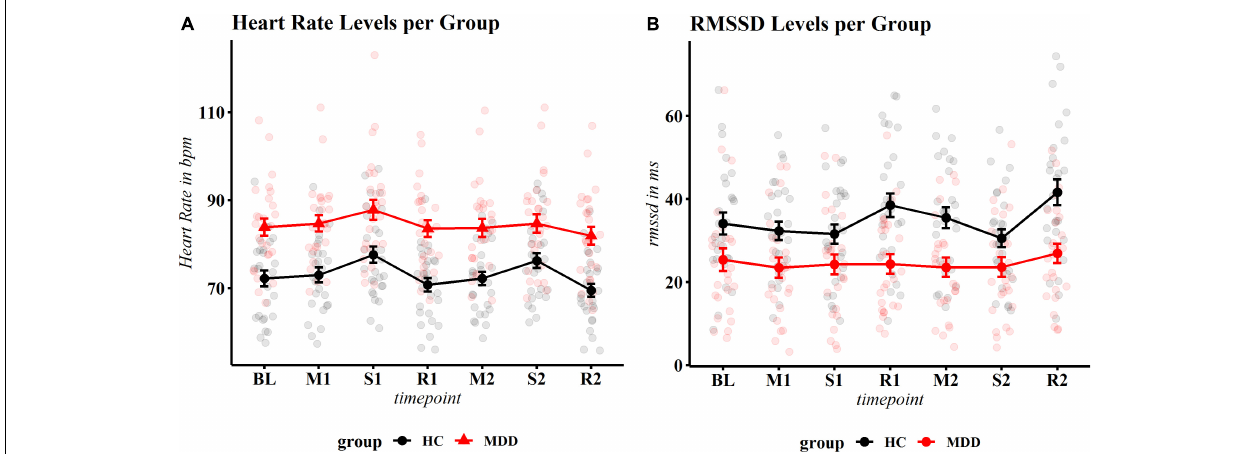
FIGURE 3 | Physiological reactivity to stress. (A) Heart rate (HR): significant overall reactivity and a group × timepoint interaction occurred. Controls show significant reactivity and recovery, while patients show an increase of HR to the first stressor and a decrease during recovery 1, but no longer react to the second stressor (neither compared to BL nor compared to recovery 1). (B) Root mean square of successive differences (RMSSD). Controls show significant response after the first stressor (recovery 1), the second stressor and second recovery, MDD patients show no fluctuation at any time point. Heart rate is displayed in beats per minute; MDD, Major Depressive Disorder; HC, healthy controls. TABLE 2 | Results of planned within group contrasts for split linear mixed models for HR reactivity. Controls Patients with MDD Contrast